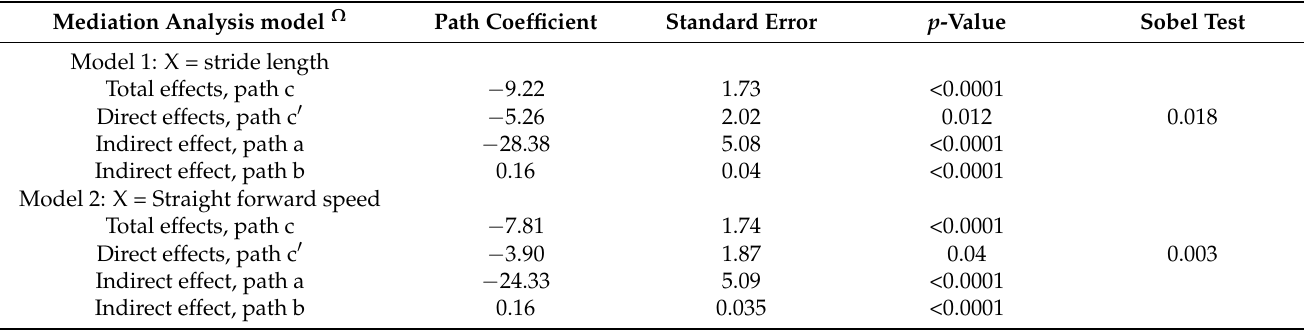
Table 7. Potential UPDRS total score mediators of stride length and speed on the risk of